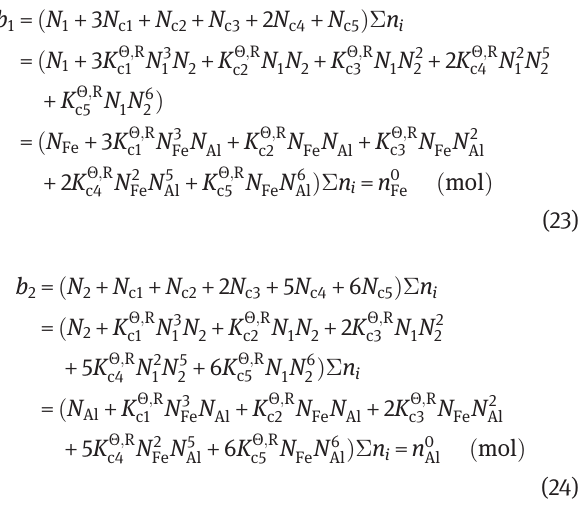
N c i of five molecules using based on the mass action law are summarized in Table 4.